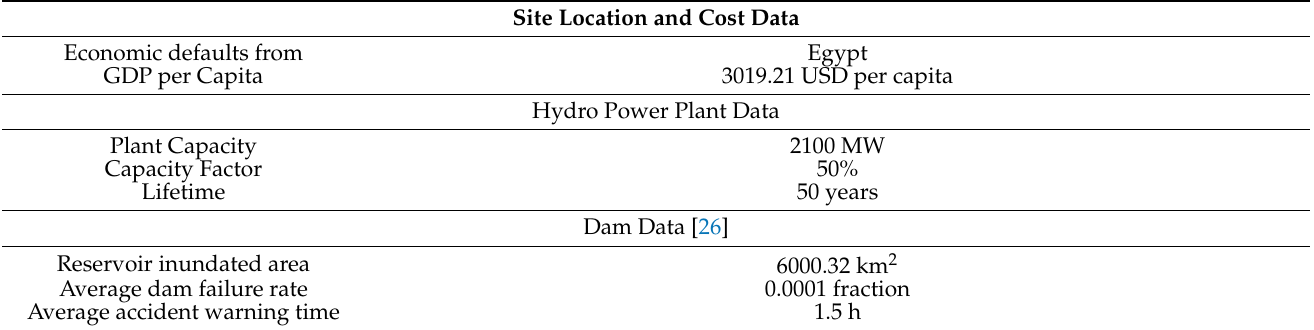
Table 4. Input data of the Aswan High Dam hydropower plant to